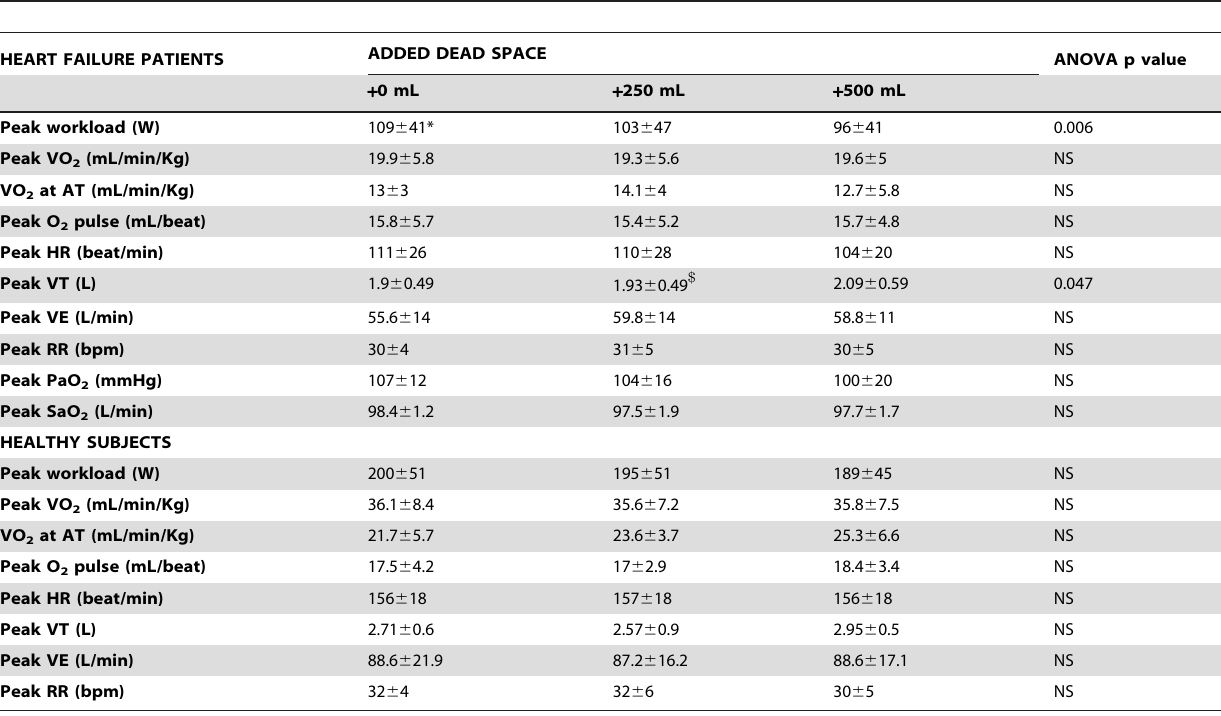
Table 2. Cardiopulmonary exercise testing data in heart failure patients (upper panel) and healthy subjects (lower panel) with 0 mL, 250 mL and 500 mL of additional dead